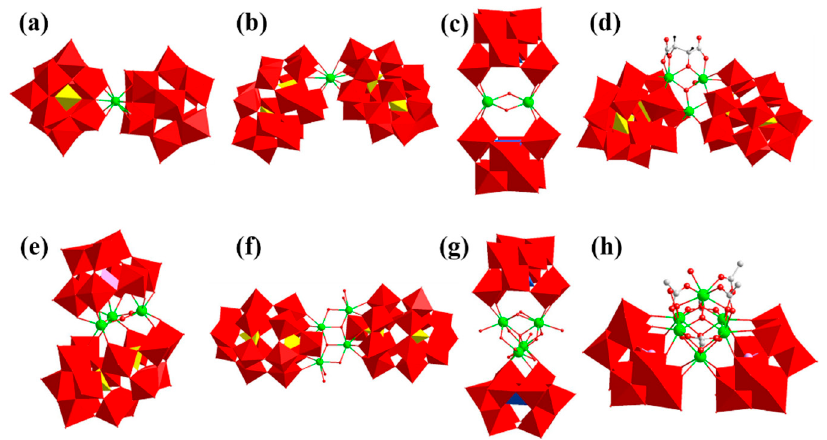
Figure 4. The ball ‐ and ‐ stick and polyhedral illustration of ( a ) [Zr(PMo 12 O 40 )(PMo 11 O 39 )] 6 − polyoxoan ‐ ion, ( b ) [Zr( α 2 ‐ P 2 W 17 O 61 ) 2 ] 16 − polyoxoanion, ( c ) [( γ ‐ SiW 10 O 36 ) 2 Zr 2 ( μ ‐ OH) 2 ] 10 − polyoxoanion, ( d ) {[ α